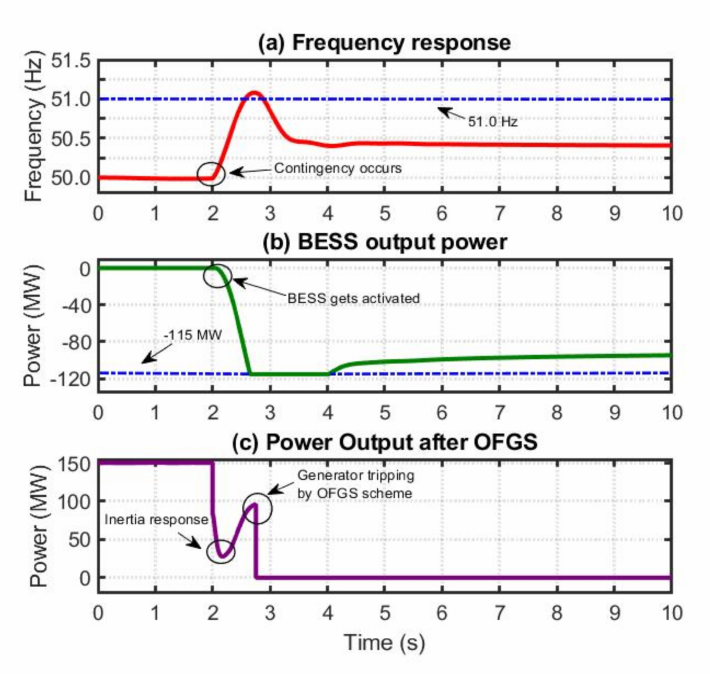
Figure 16. Frequency responses, BESS output and Over-Frequency Generator Shedding (OFGS) due to 500-MW interconnection trip in three-machine case.